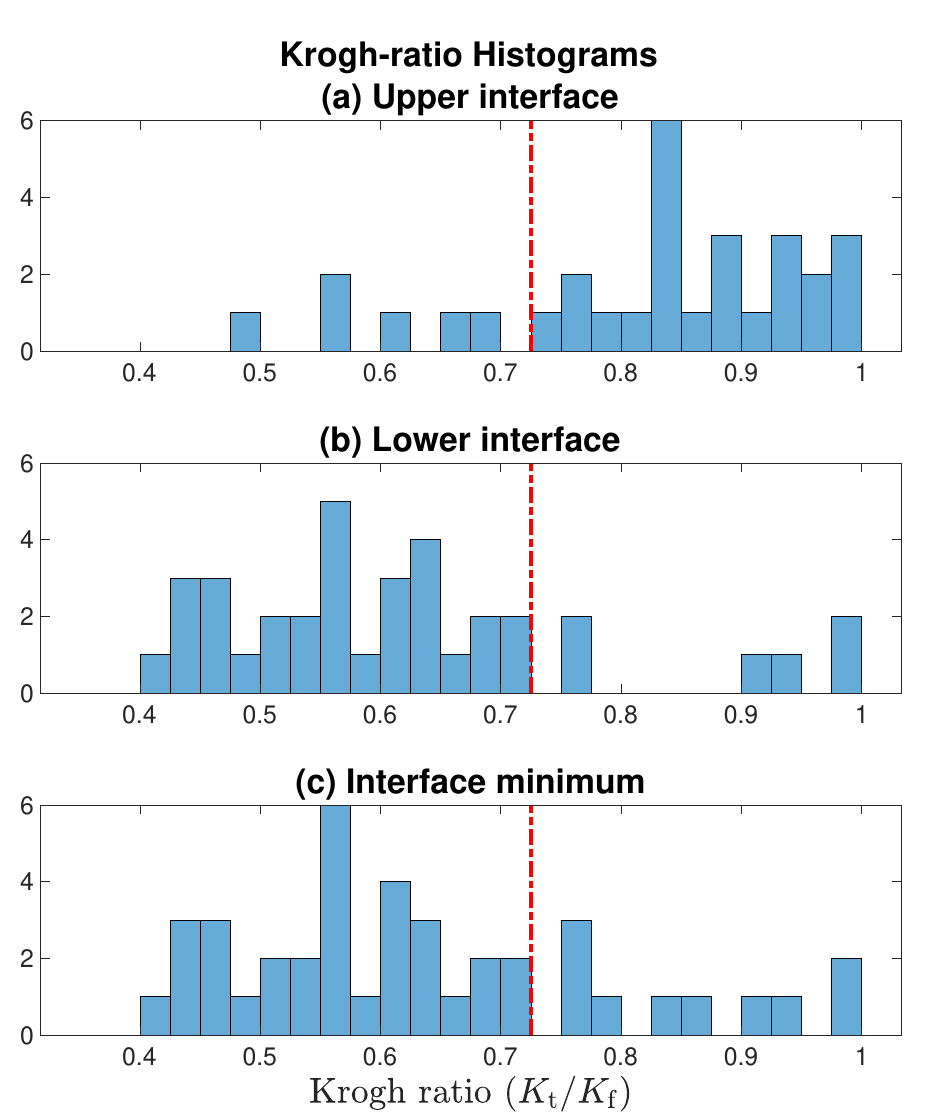
Figure 9. Histograms for Krogh ratios aggregated over [v3, v4, v5] datasets illustrated in Figure 7, but restricted to domain ( K t / K f ) ≤ 1.0. Red-dashed line marks the accept/reject boundary set at 0.725: only Krogh ratios below cutoff are associated with a well-defined stationary layer. Comparing panels ( a , b ), the lower tissue–fluid interface is more likely to form a nonflowing boundary layer. In panel ( c ), for each profile, the smaller of the [upper interface, lower interface] Krogh ratio is